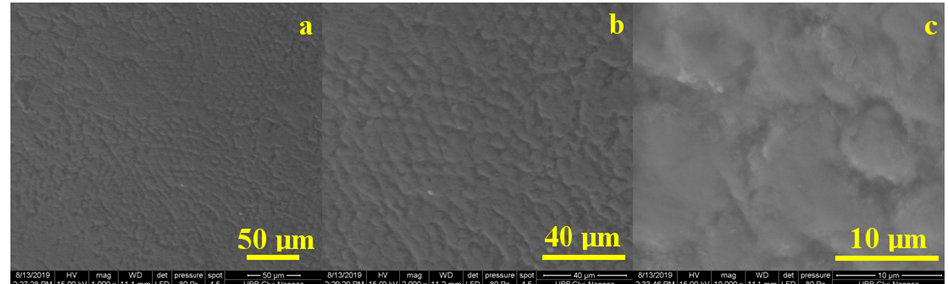
Figure 10. SEM appearance of stained and bleached enamel with experimental gel: ( a ) small magnification, ( b ) medium magnification, and ( c ) high magnification.